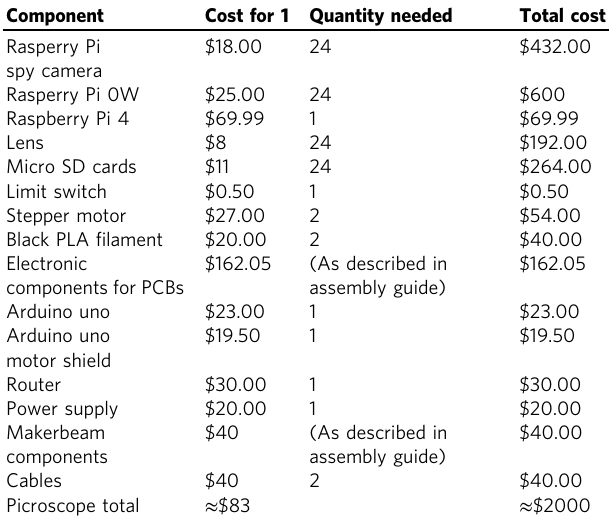
Table 2 Breakdown of cost of the